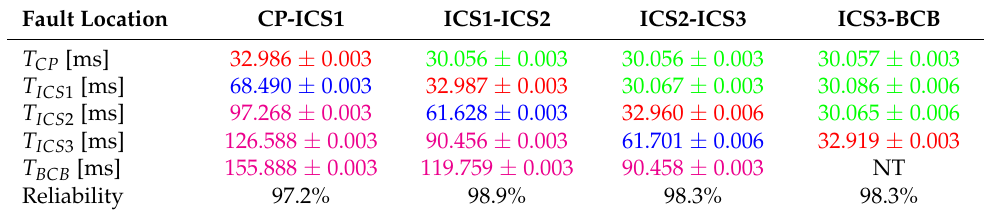
Table 10. Results obtained in urban